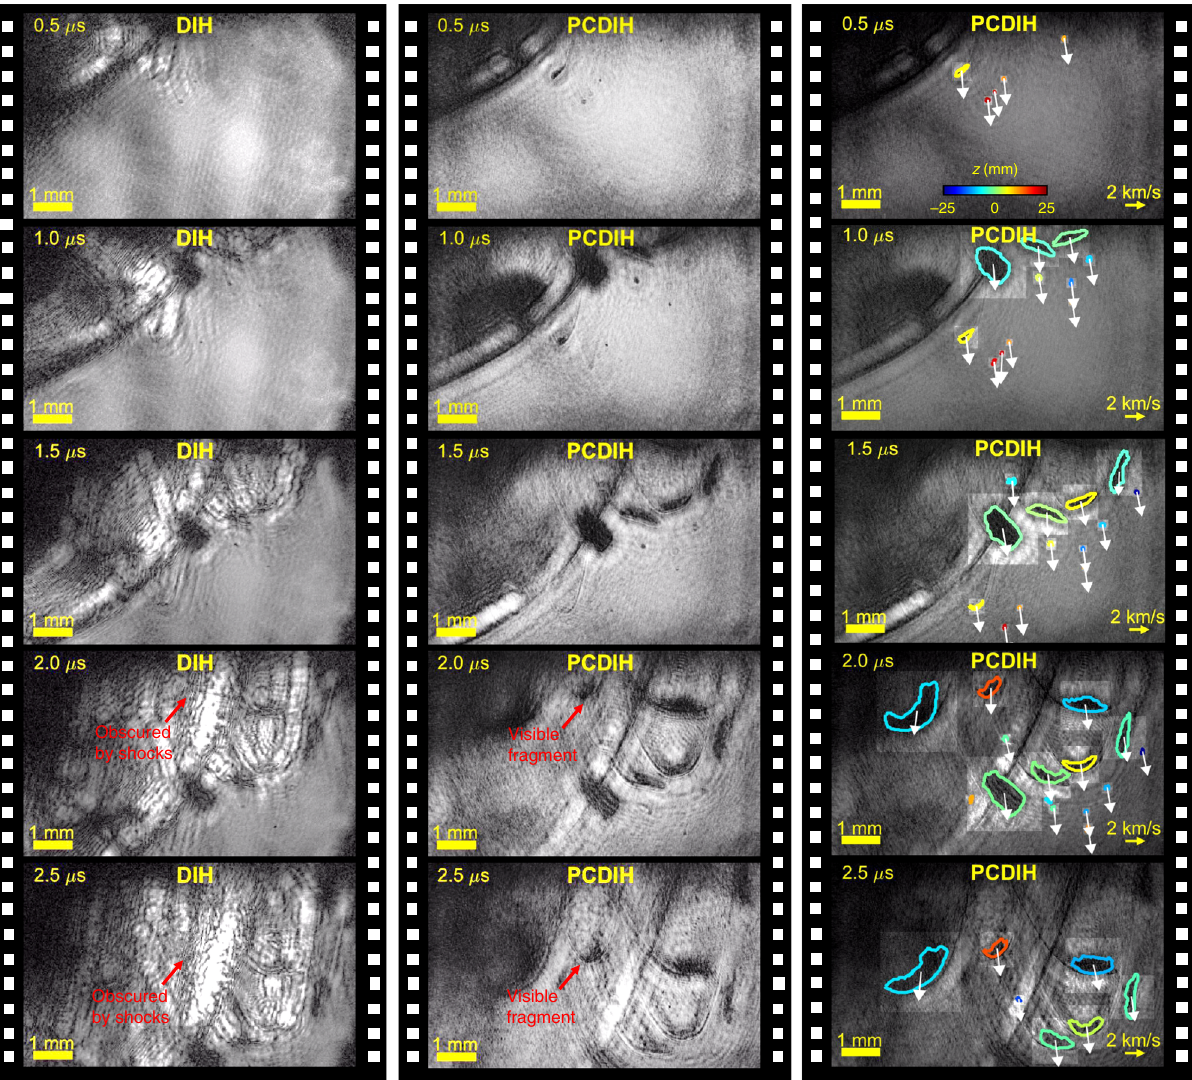
Fig. 8 Video of explosively generated hypersonic fragments collected at 2 MHz. Columns from left to right show DIH, PCDIH, and tracked PCDIH videos of the hypersonic fragments and surrounding shock-wave distortions. Late-arriving fragments generated by an explosive detonator are obscured by shock- wave phase distortion interference patterns. However, the fragments are visible and can be tracked in the PCDIH images to estimate size, three- dimensional position ( z -location illustrated by outline color), and velocity. All holograms are numerically refocused to the center of the fragment fi eld. Supplementary Movie 3 illustrates this